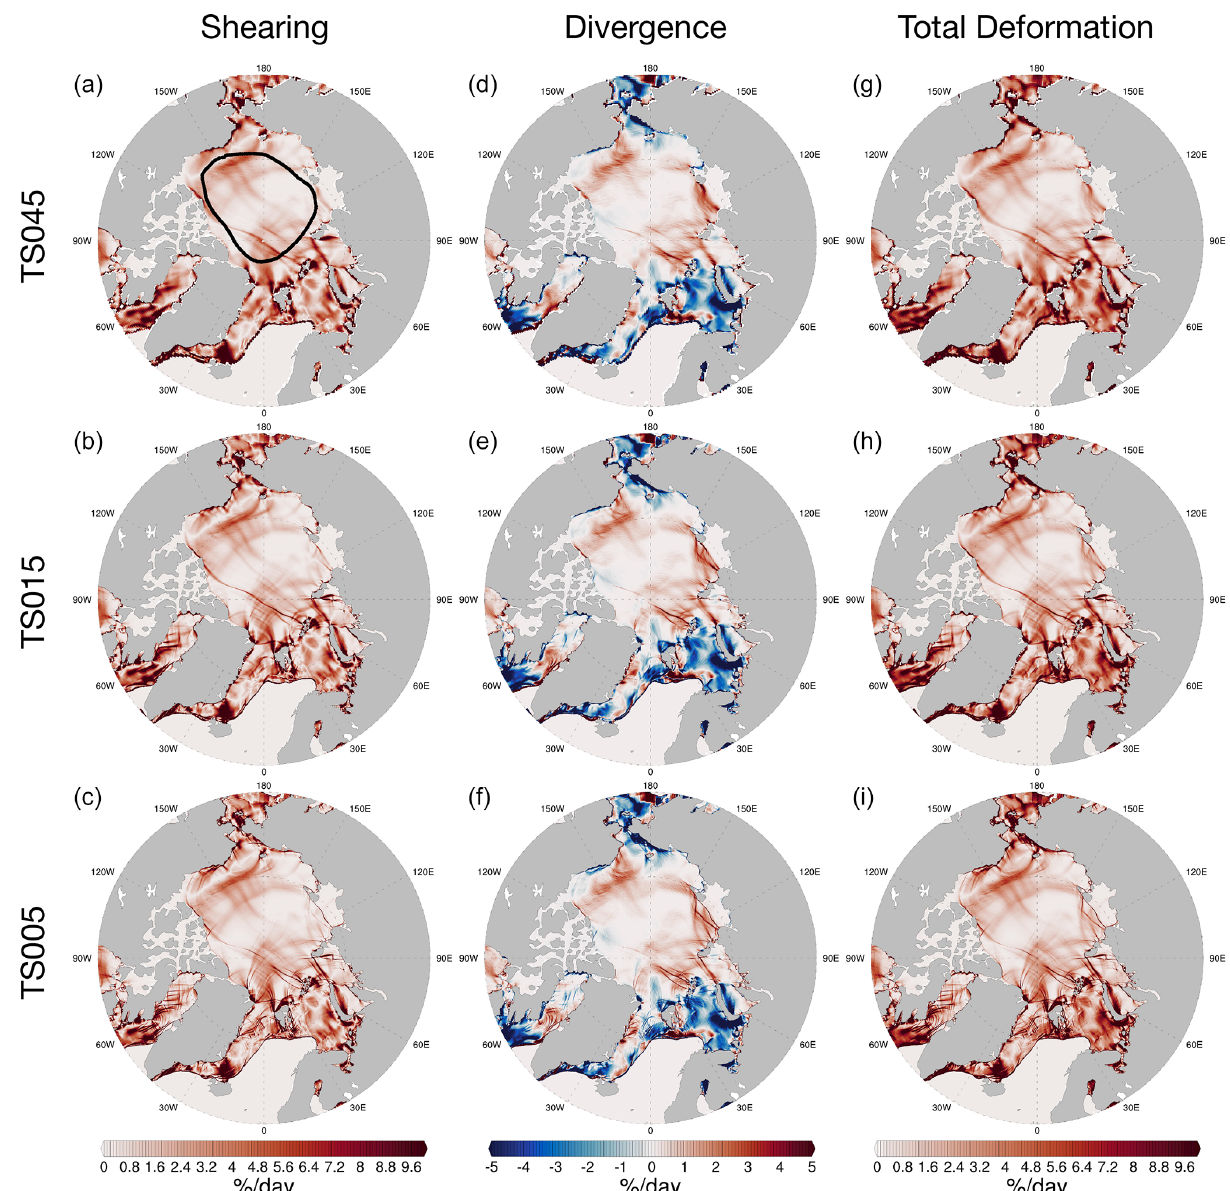
Figure 8. Same as in Fig. 7, but for 6